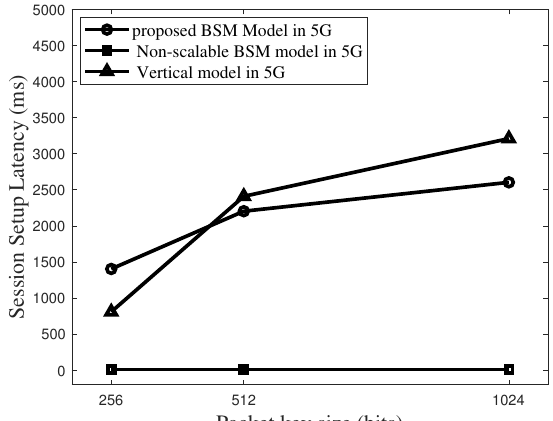
Figure 19. Total latency to set up a packet key-based secure session in 5G networks for the case size of Blind Value Vector (m) =